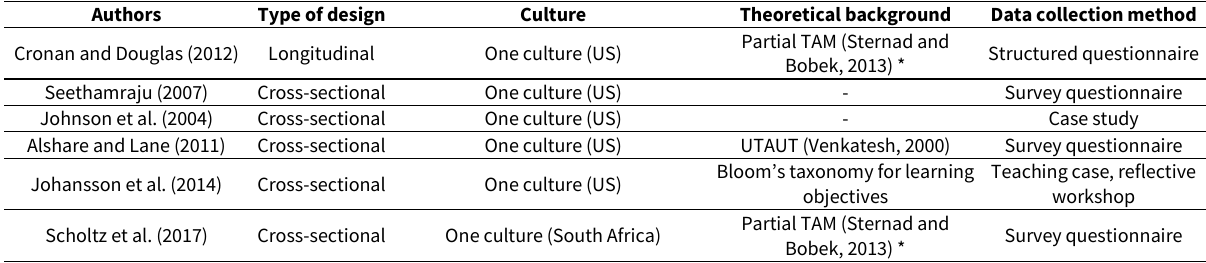
Table 1. Previous ERP studies - Educational